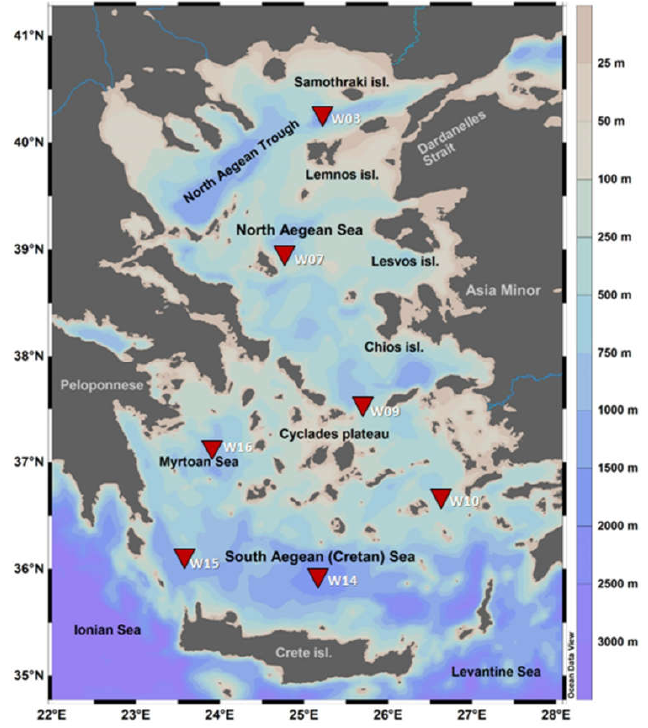
Figure 1. The sampling stations in deep basins of the Aegean Sea during 17–23 March 2017. Based on its geomorphological characteristics, the Aegean Sea can be divided into: (a) The North Aegean, an elongated area located between the northern Greek coastline and an almost linear ridge complex located around the parallel of 39 °N, and extend- ing from Evia to Skyros and then to Lesvos; (b) The Central Aegean, which includes the Cycladic plateau, is a relatively shallow plat- eau (average depth < 350 m) surrounded by small basins (up to 1000 m deep), includ- ing the relatively extensive eastern continental shelf of Asia Minor (the Central Ae- gean has a transitional character with its terrestrial inflows, which are imported along its eastern part) and; (c) The South Aegean, which is located southwards of the Greek volcanic arc (Cretan Sea); it is enriched with high percentages (>50%) of biogenic material, due to the char- acteristic small continental origin inflows, although it is a more oligotrophic system than the North Aegean Sea [7]. In order to study the current level of 137 Cs in the water masses of the Aegean Sea, a sampling cruise was carried out with the oceanographic vessel “AEGEAON” of the Hel- lenic Centre for Marine Research (HCMR) from 17 to 23 March 2017. Seawater samples